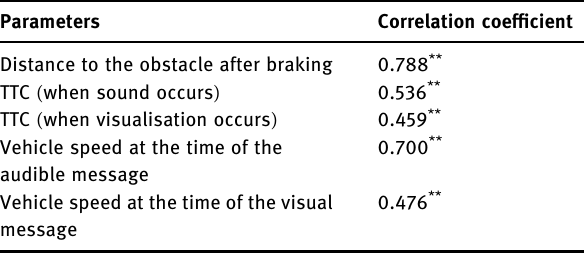
Table 14: Correlation of vehicle speed at the time of the audible message with the rest of the parameters Parameters Correlation coe ffi cient